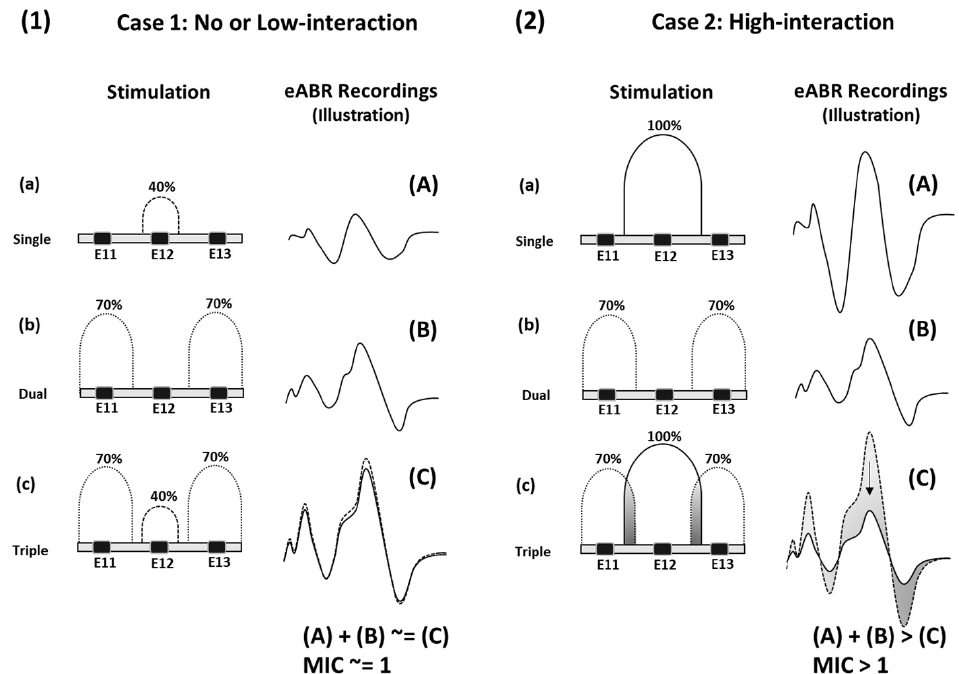
Figure 1. Schematic overview of the stimulation conditions (left side, small letters) and eABR recordings (right side, capital letters) illustrating two hypothetical cases: no or low-interaction—( 1 ) left pane, case 1: E12 stimulating at 40% and high-interaction—( 2 ) right pane, case 2: E12 stimulating at 100%. In ( 1c ): low intensity stimulation at E12 causes no or low interactions, the recording ( 1C ) (solid line) is close or equal to the sum of recordings ( 1A , 1B ) (dashed line), obtained when stimulating from the mid-electrode ( 1a ) or flanking electrodes ( 1b ) only, the MIC value is close to 1. In ( 2c ): high intensity stimulation at E12 causes high interactions, the recording ( 2C ) (solid line) is lower in amplitude than the sum of recordings ( 2A , 2B ) (dashed line), obtained when stimulating from the mid-electrode ( 2a ) or flanking electrodes ( 2b ) only, the MIC value is increasing. Intensities are expressed in % of the clinical electric dynamic range (EDR) of the electrode. Grey shaded areas represent electrical interactions in ( 2c ) and their effect on the eABR recording in ( 2C ).